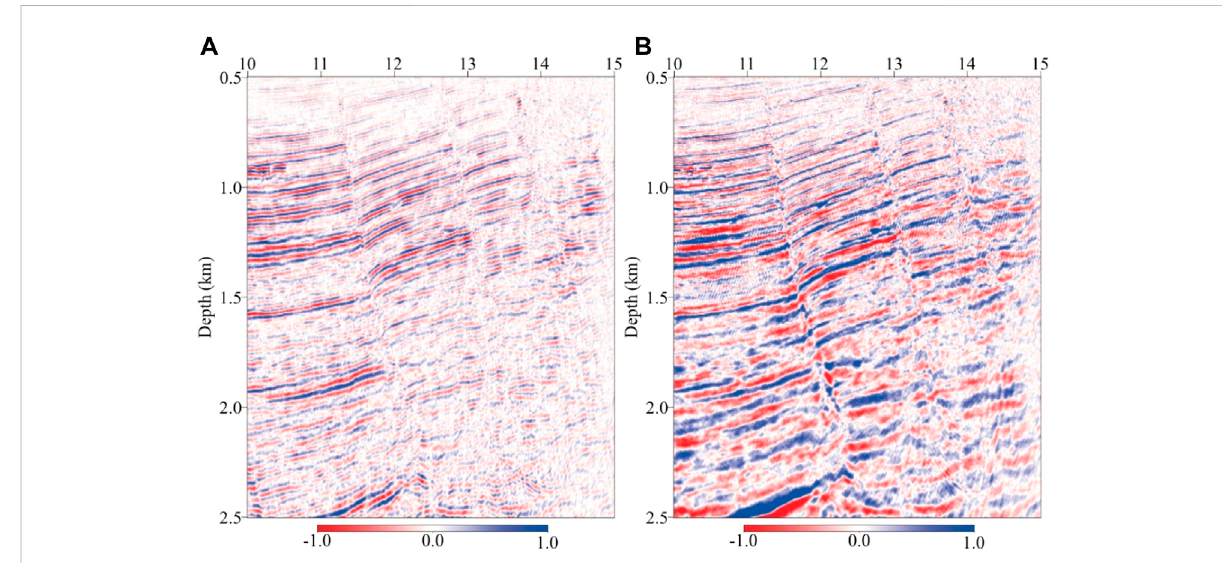
ZoomedviewsofdashedboxinFigure17. (A) ViscoacousticVTIRTM,and (B) viscoacousticVTILSRTM.Andthecolorscalesofalltheimagesare the same.